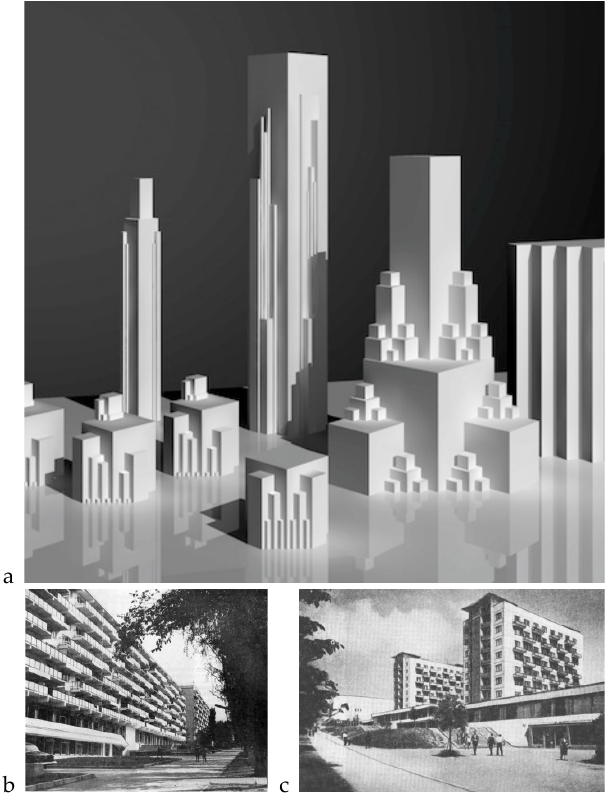
Figure 7. ( a ) Malevich‘s architectons.https://thecharnelhouse.org/2012/11/22/the-arkhitektons-and-planets-of-kazimir-malevich (accessed on 8 June 2022); ( b ) Alma-Ata. Residential buildings on Lenin Avenue. Architects N. Ripinsky, T. Basenov, A. Petrov, etc.; ( c ) Vilnius. Žirmunai. Microdistrict D-18. Architects B. Kasperaviciene, B. Kruminis. 1967. Type of development